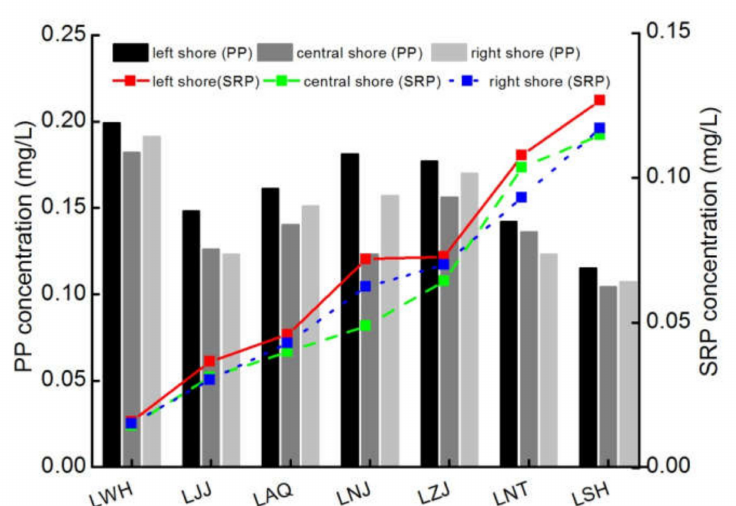
Figure 7. Comparison of PP and SRP concentrations in surface water samples from the lower reaches of urban river stretches. Legend: the lower reach of Wuhan (LWH), the lower reach of Jiujiang (LJJ), the lower reach of Anqing (LAQ), the lower reach of Nanjing (LNJ), the lower reach of Zhenjiang (LZJ), the lower reach of Nantong (LNT), and the lower reach of Shanghai